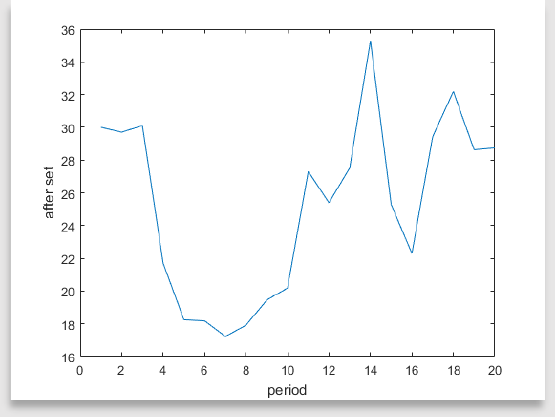
Figure 12. Graphs were drawn for potential difference data after adjustment for 20 time periods.